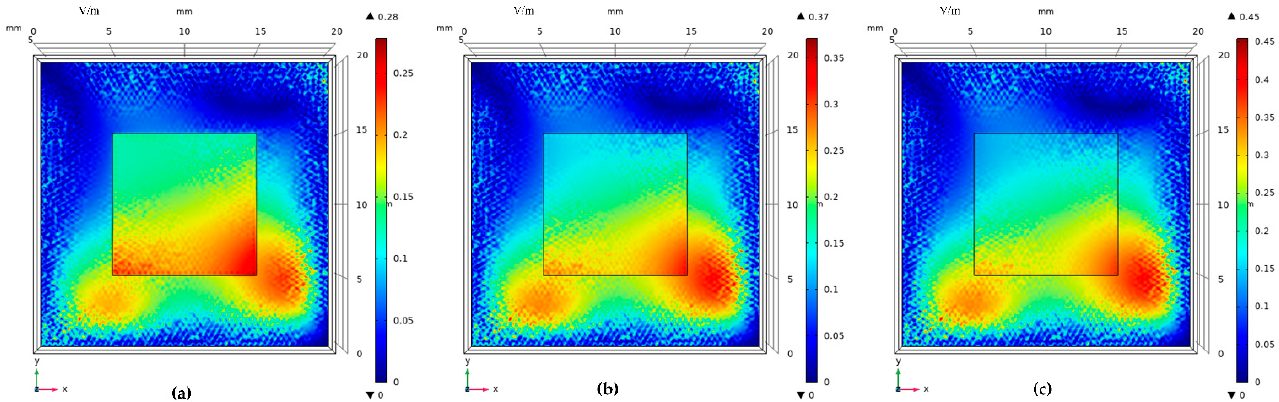
Figure 19. Surface electric field distribution of graphene copper-clad electrode plate: ( a ) f = 30 MHz; ( b ) f = 60 MHz; and ( c ) f = 90 MHz.